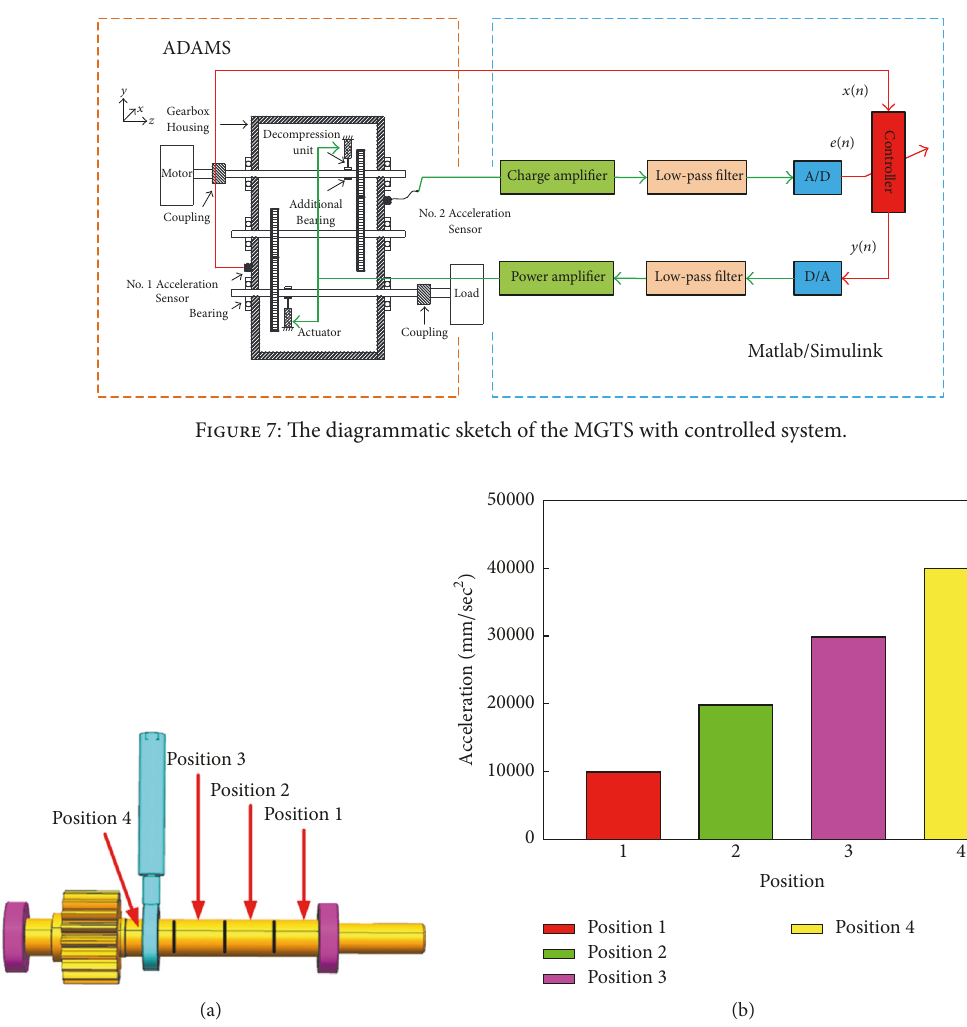
Matlab. Then the cosimulation control structure based on PID and FxLMS algorithm is established in